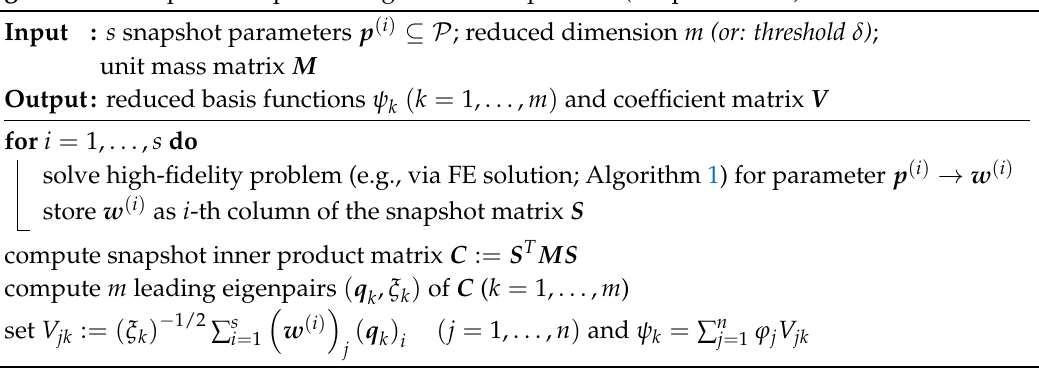
Algorithm 2: Snapshot Proper Orthogonal Decomposition (Snapshot